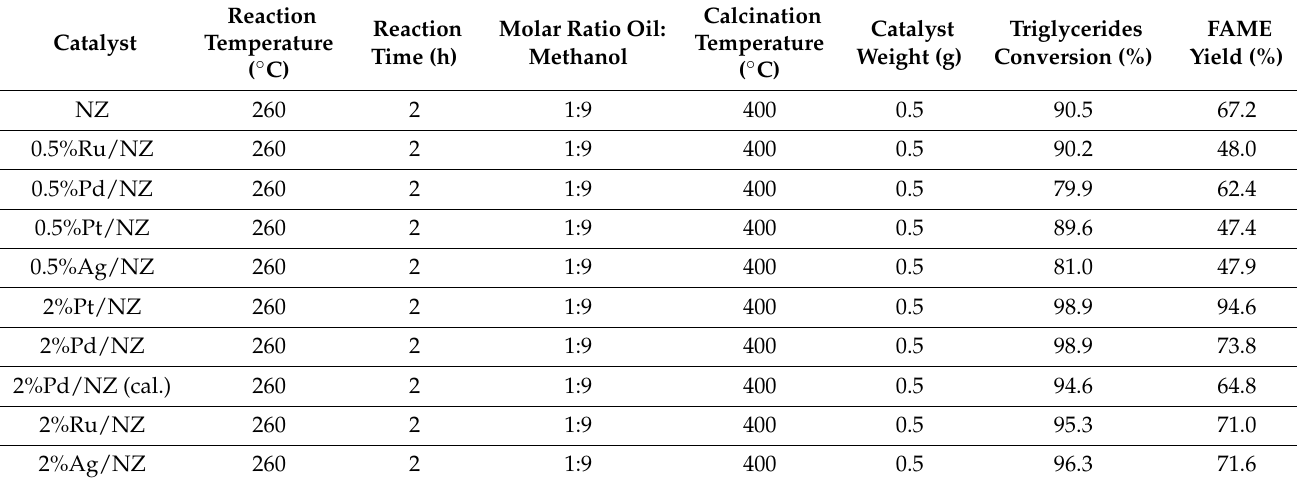
Table 2. The results of the transesterification process performed over various monometallic catalysts activated in a mixture of 5%H 2 –95% Ar at 300 ◦ C for 1.5 h, calcined system, or pristine natural zeolite (NZ)